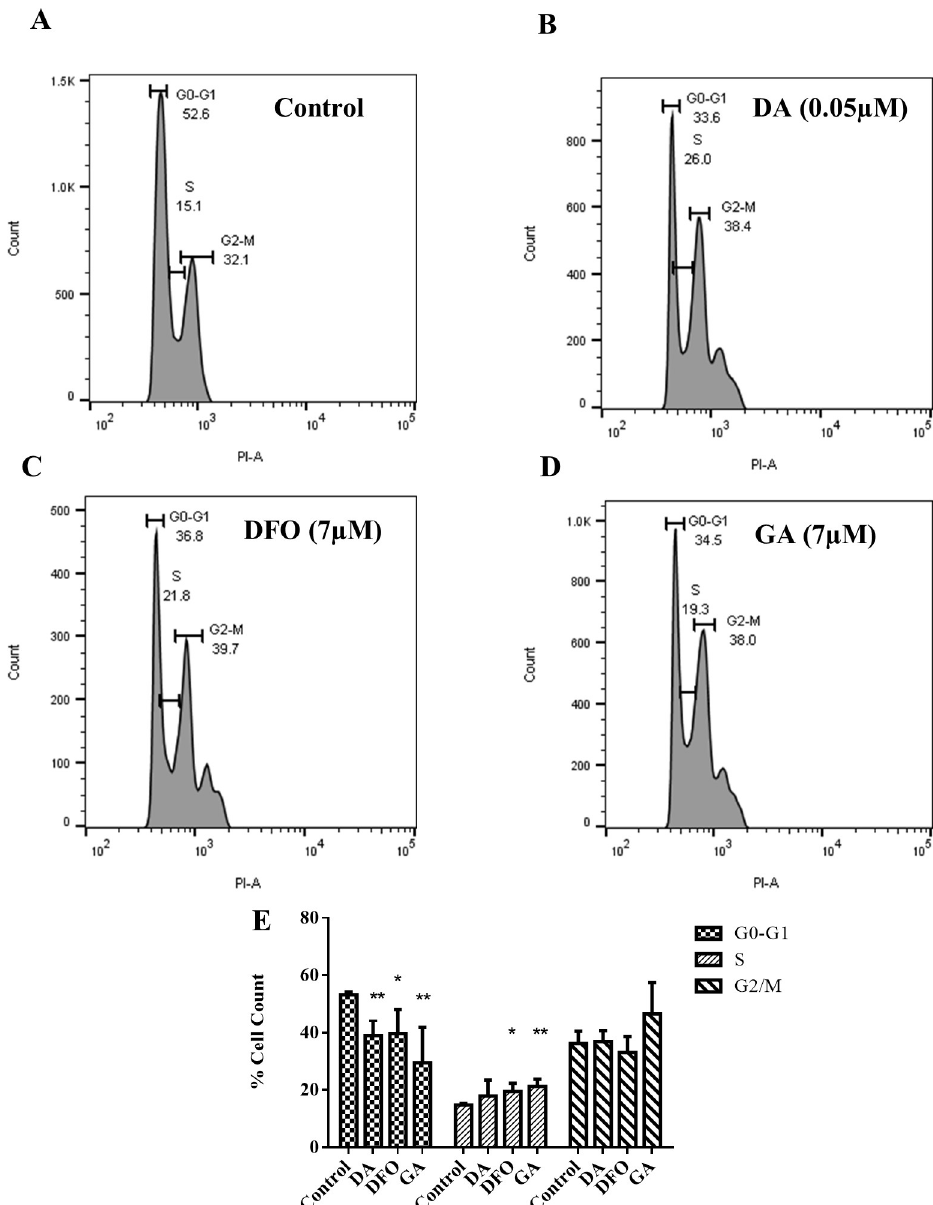
Fig 6. Effects of compounds on T . brucei cell cycle. Flow cytometry outputs (A) untreated control (B) diminazene aceturate (0.05 μ M) (C) deferoxamine (7 μ M) (D) gallic acid (7 μ M). (E) Percentage cell count at each cell cycle phase. Results are represented as average ± SD. Statistical significance was determined using unpaired t test by comparing the treated and the control for each phase, p < 0.05. Data in (E) represents an average of four independent experiments.